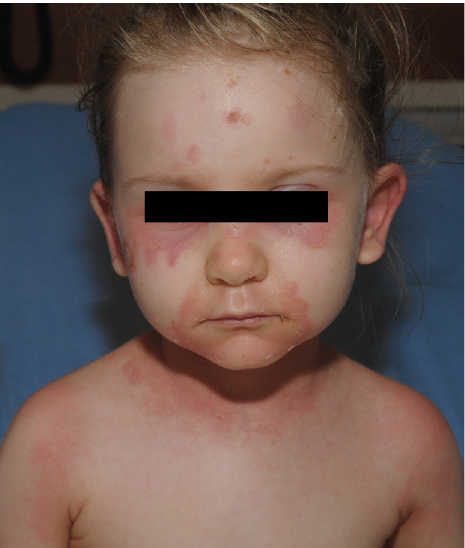
erythematous, macular